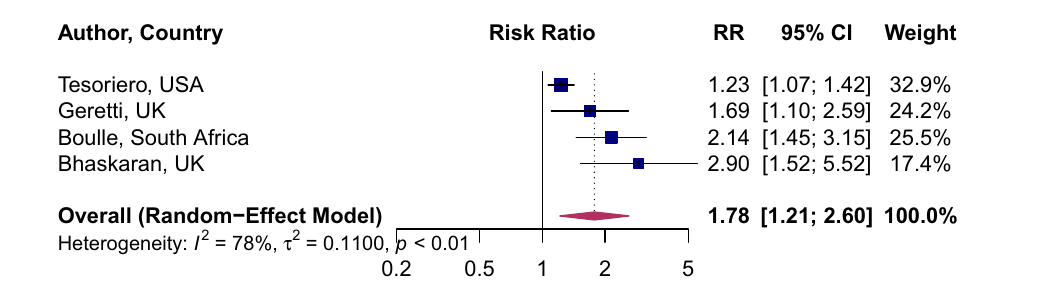
Figure 4. Prevalence of HIV in patients hospitalized for COVID-19 stratified by country. Blue squares and their corresponding lines are the point estimates and 95% confidence intervals per each study. Maroon diamond represents the pooled effect estimate.